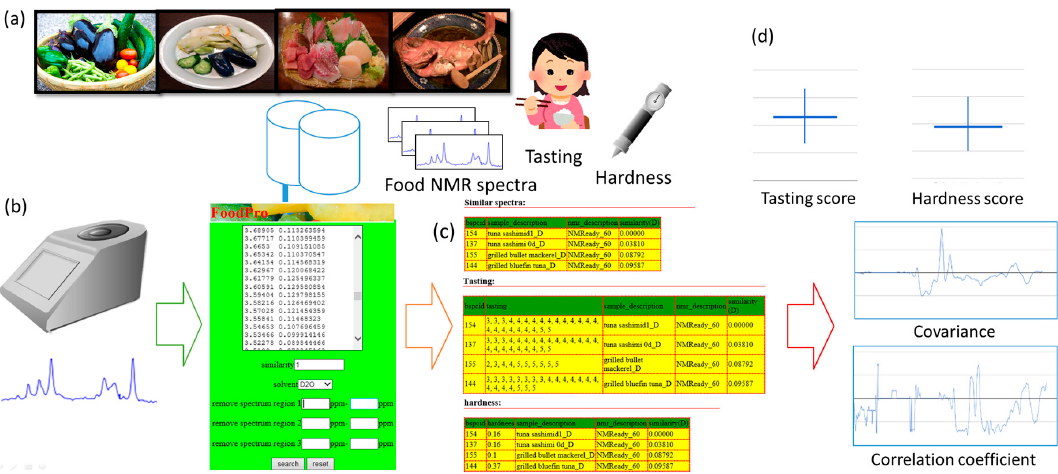
Figure 1. FoodPro summary with screenshots. ( a ) Construction of a database for NMR spectra associated with food processing, tasting, and hardness of which the experimental data were newly measured and accumulated into FoodPro; ( b ) User submits a food 1 H NMR query on the web portal of FoodPro; FoodPro ( c ) searches similar NMR spectra within a specified similarity threshold with tastings and hardnesses, and ( d ) suggests estimated scores for tasting and hardness based on the experimental tasting and hardness data in the database. Further, FoodPro computes covariance and correlation spectra between tasting (or hardness) and NMR bin intensities along chemical shift.